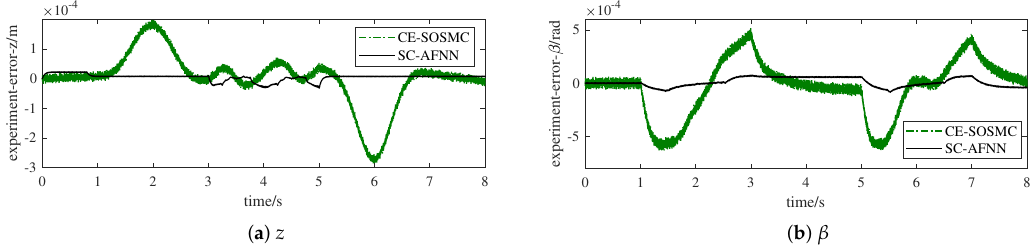
Figure 10. The experimental tracking error curves of the UBSHR’s end-effector (desired trajectory 1). ( a ) Experimental tracking error curves in z -direction (8 s); ( b ) Experimental tracking error curves of β (8